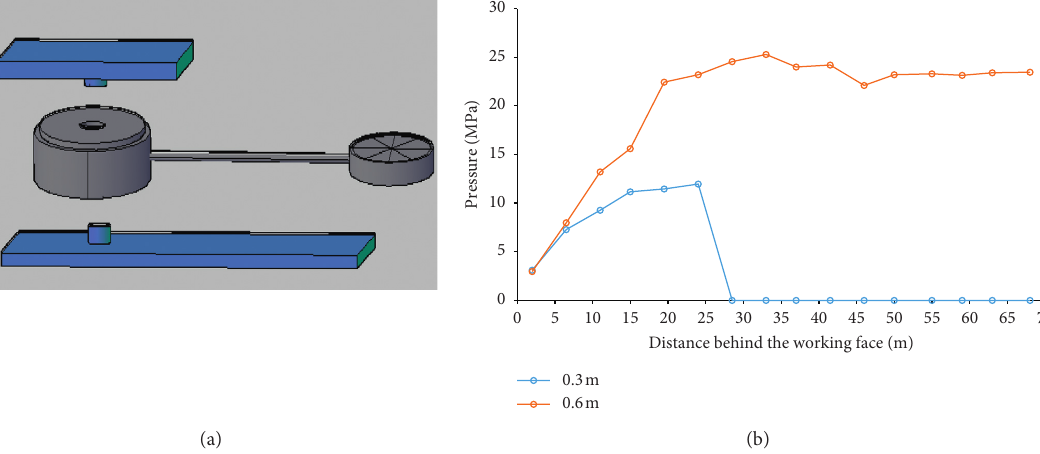
Figure 6: The filling body pressure monitoring. (a) The pressure gauge for the filling body. (b) The pressure gauge reading of the filling